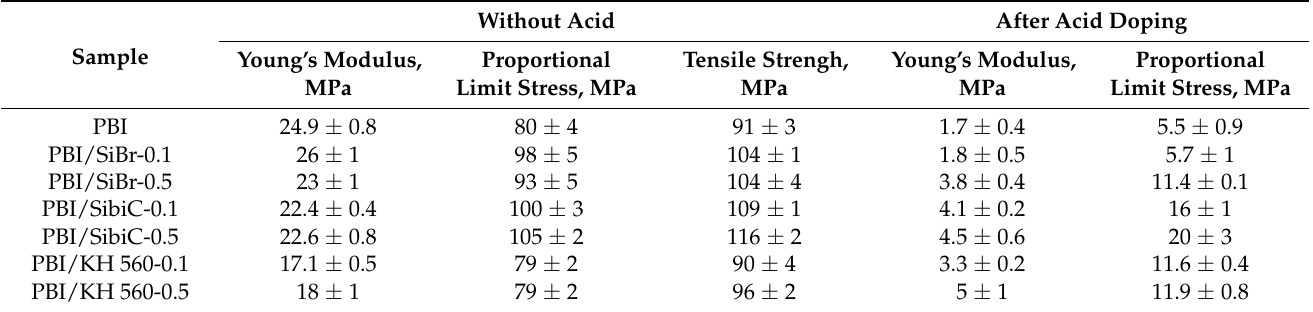
Table 3. The mechanical properties of PBI and crosslinked membranes before and after doping with phosphoric